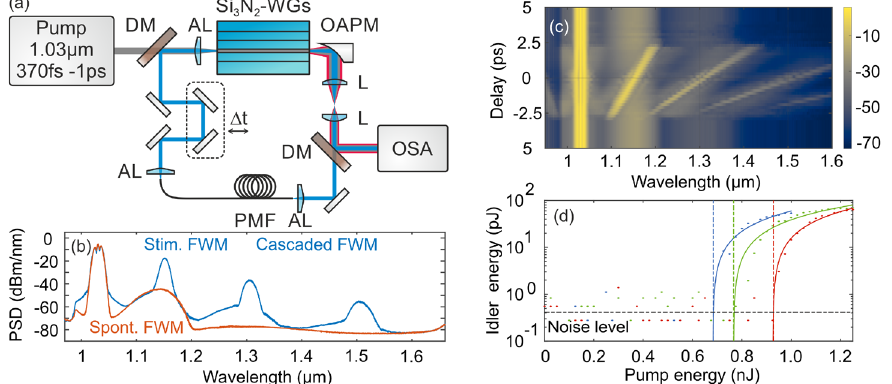
Fig.1 (a) Schematic of the experimental setup. (b) Spectra of spontaneous (red) and stimulated FWM (blue). (c) Color-coded output spectra of the WOPO as a function of the relative delay of the signal pulses at 1.25nJ pump energy. (d) External output energy of the WOPO as a function of external pump energy with different pump pulse durations (500, 700, and 900fs). The presented WOPO showed 27(cid:2)dB amplification in the idler sideband, followed by two stimulated cascaded FWM sidebands because of phase-matching between pump and idler waves. The tuning of the WOPO was accomplished by changing the free-space delay, thus, varying the temporal delay between stretched signal and pump pulses. As a result, the output idler wavelength was tuned from 1099(cid:2)nm to 1194(cid:2)nm, which corresponded to the bandwidth of the measured spontaneous FWM spectrum. The numerical calculations showed that, by engineering the waveguide dispersion, the accessible tuning range of the idler sideband could extend into 2(cid:2)μm which is a compact pump source for various applications such as nonlinear microscopy. Moreover, to determine the oscillation threshold of the WOPO, the output idler energy versus pump energy was measured (Fig.1(d)), indicating an oscillation threshold at 0.68(cid:2)nJ for 500 fs pump pulse duration, which increased with longer pump pulse duration. The maximum idler pulse energy of 63(cid:2)pJ was extracted from the WOPO when pumped with 1.25(cid:2)nJ at